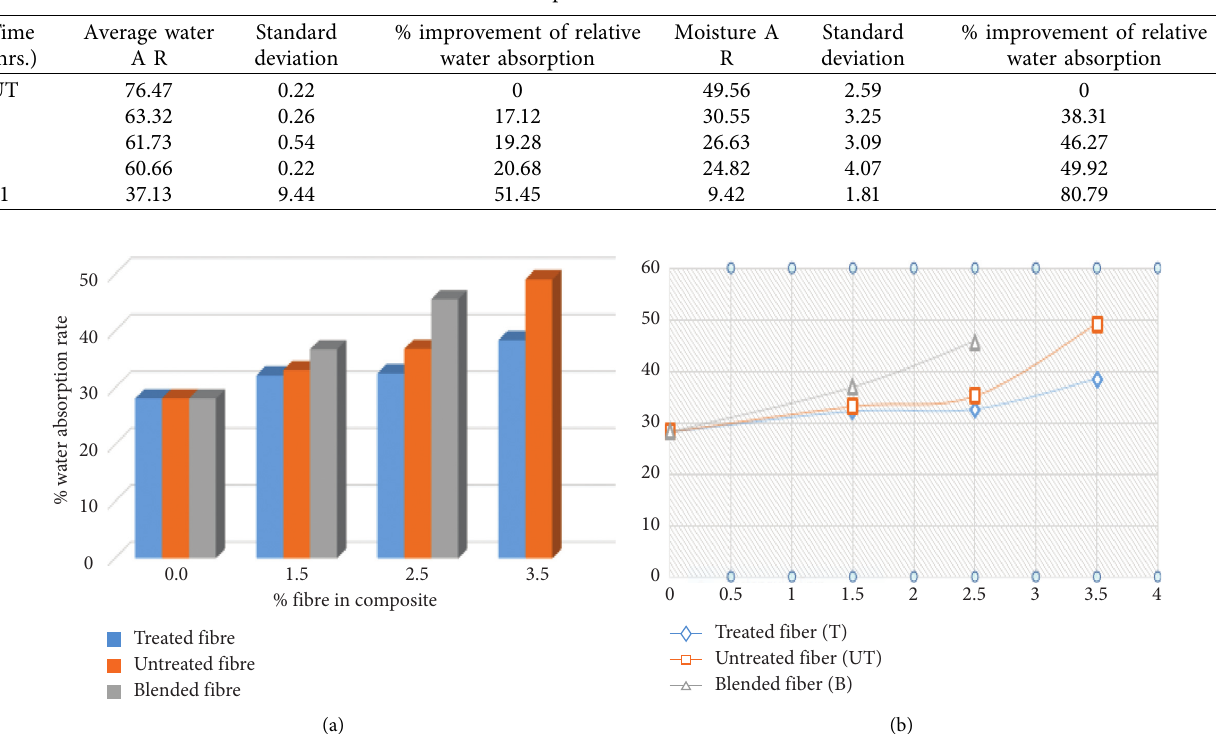
Table 3: Water and moisture absorption rates for the treated and untreated fibres.